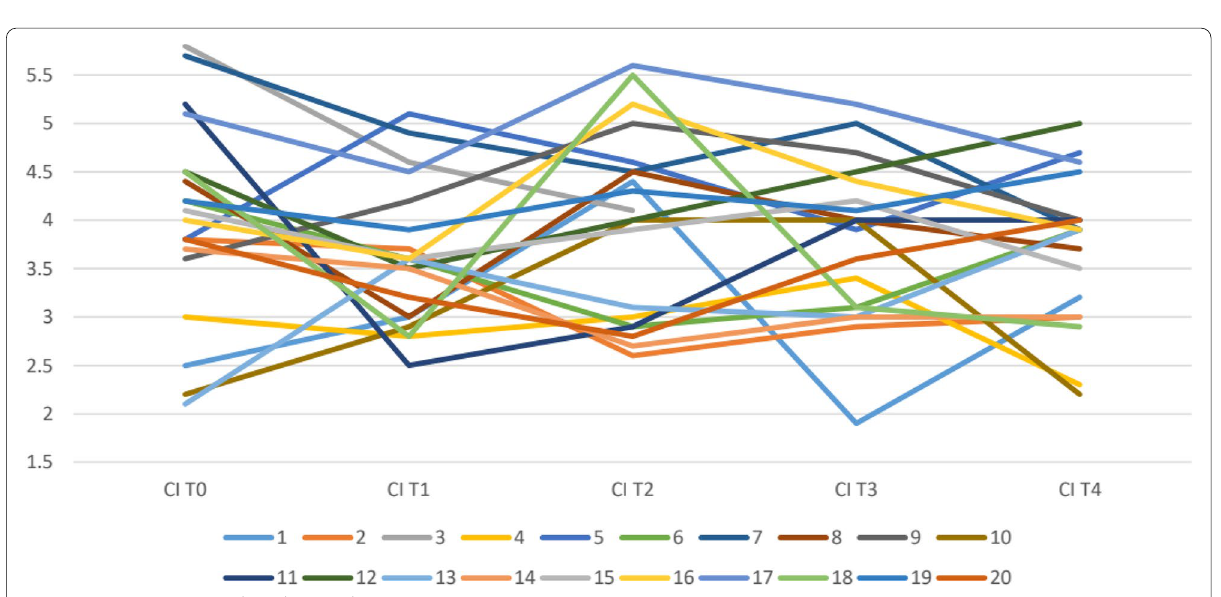
Fig. 3 Group I Patients Stroke Volume Indices (SVI),